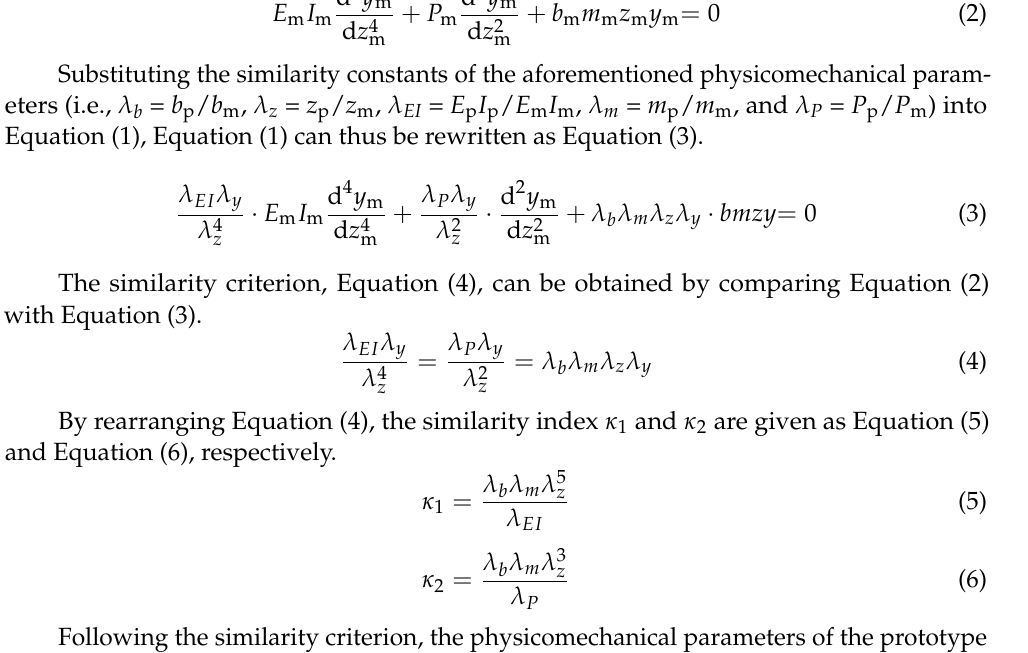
Table 1. Physicomechanical parameters of prototype and model tests. Parameters Prototype Model Calculative width of piles (m)